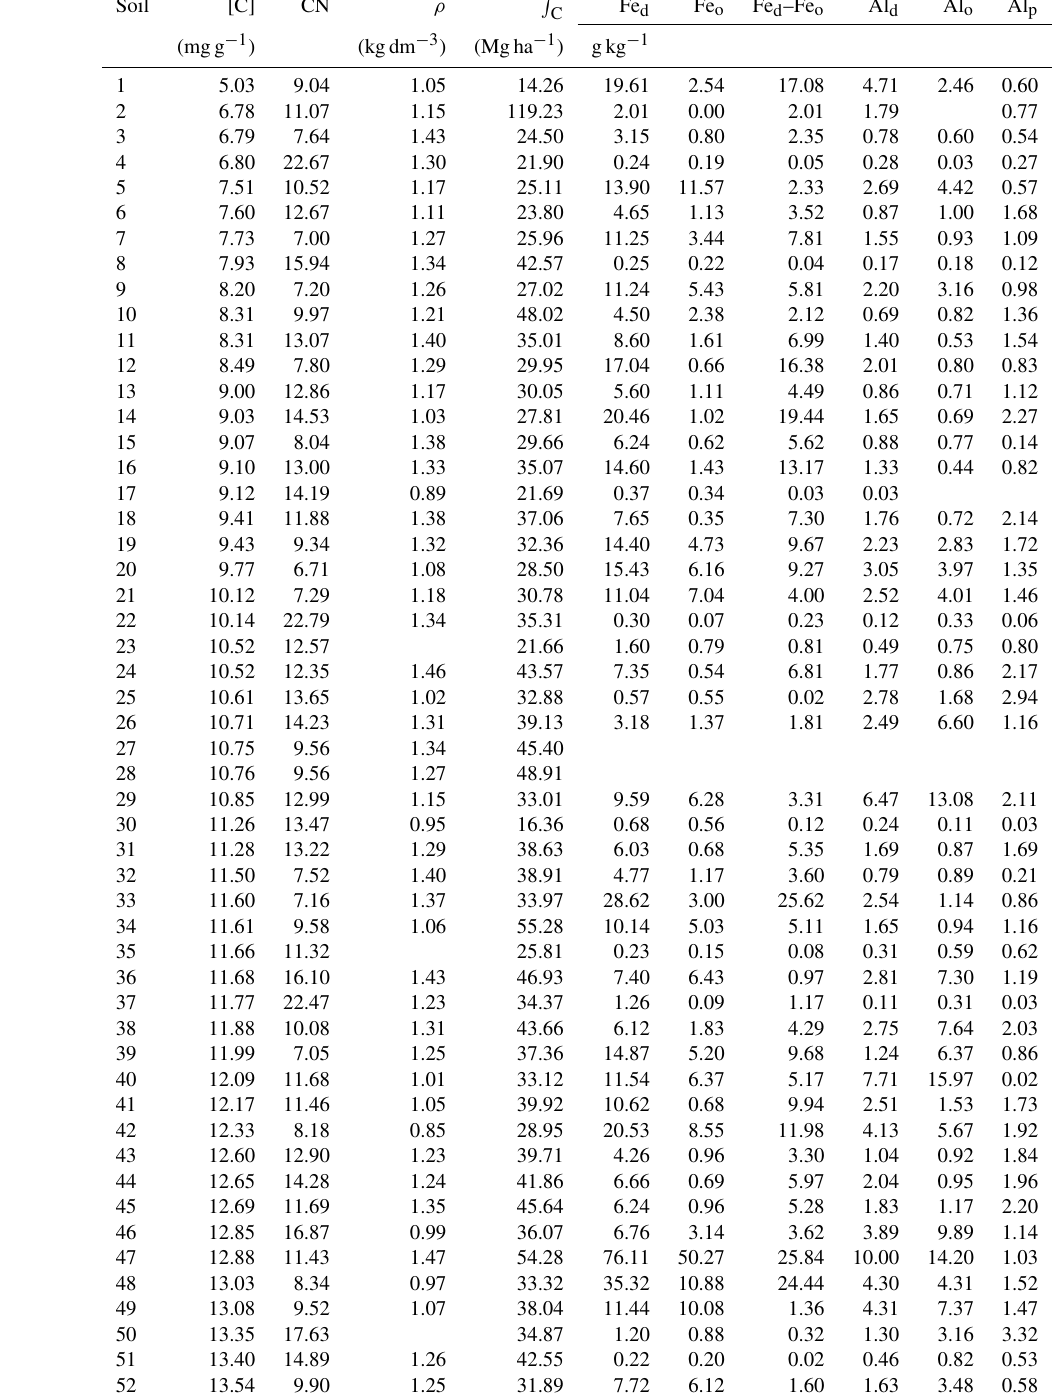
Table A1. Soil carbon and associated measures of the study soils (0.0–0.3m). [C]: C concentration; CN: carbon–nitrogen ratio; ρ : bulk density; (cid:82) : total soil C; Fe d : dithionite extractable iron; Fe o : oxalate extractable iron; Al d : dithionite extractable aluminium; Al o : oxalate C extractable aluminium; Al o : pyrophosphate extractable